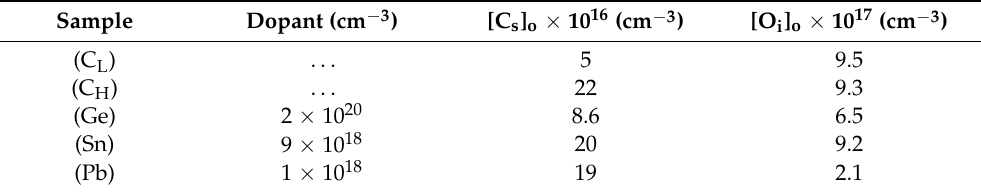
Figure 3. The production of the VO defects as a function of the isovalent dopant covalent radius Reproduced with permission from [143]. American Institute of Physics, 2012. Table 2. The concentrations of Ge, Sn, and Pb-doped samples, as well as the concentrations of the O i and C s of the used samples in Figure 3